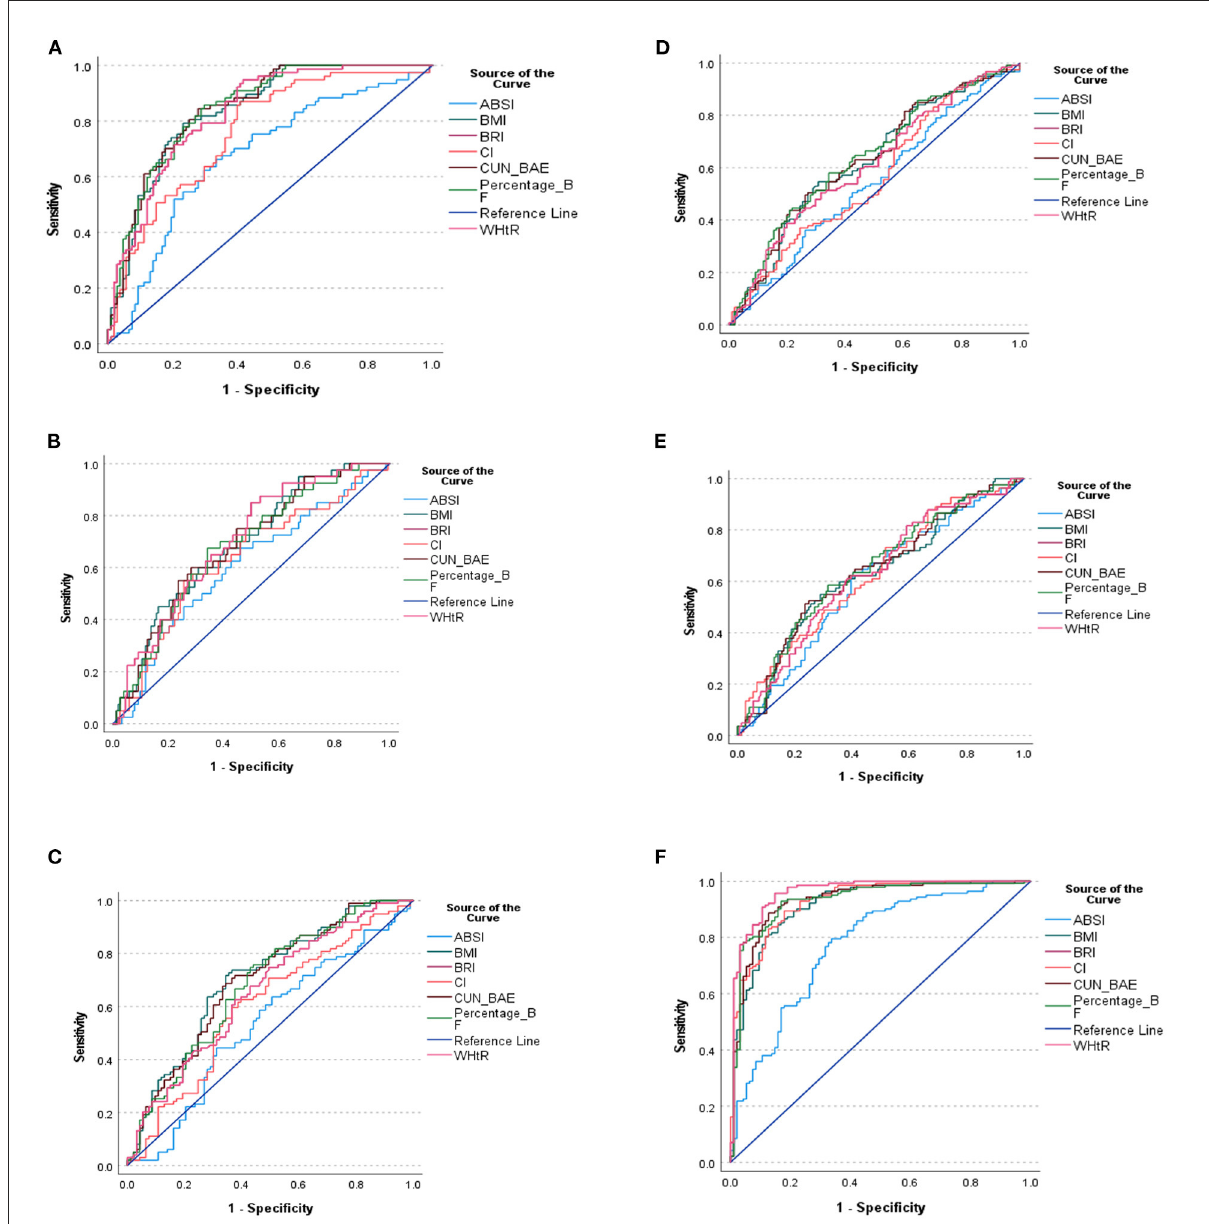
FIGURE2 (A) ROC curve of the anthropometric indices for the prediction of MetS. (B) ROC curve of the anthropometric indices for the prediction of triglyceride. (C) ROC curve of the anthropometric indices for the prediction of HDL-C. (D) ROC curve of the anthropometric indices for the prediction of FBG. (E) ROC curve of the anthropometric indices for the prediction of Hypertension. (F) ROC curve of the anthropometric indices for the prediction of WC. (A–F) shows the ROC curve of the anthropometric indices cut off points for the prediction of MetS and its